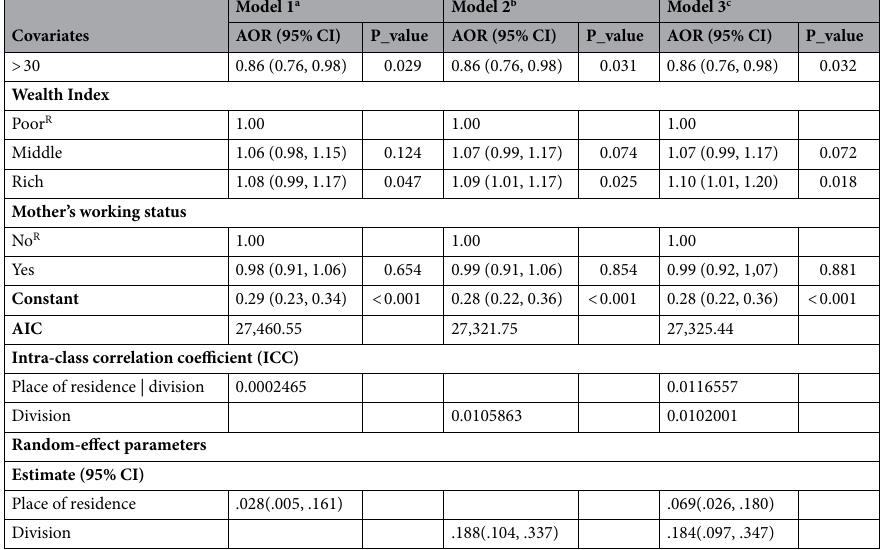
Table 2. Adjusted odds ratio for multilevel logistic regression models to EIBF of Bangladeshi children by different socio-economic and demographic factors, BDHS 2004–2014. R Reference category. a Model 1: Two- level logistic regression model considering place of residence as level 2 factor. b Model 2: Two-level logistic regression model considering division as level 2 factor. c Model 3: Three-level logistic regression model considering place of residence as level 2 and division as level 3